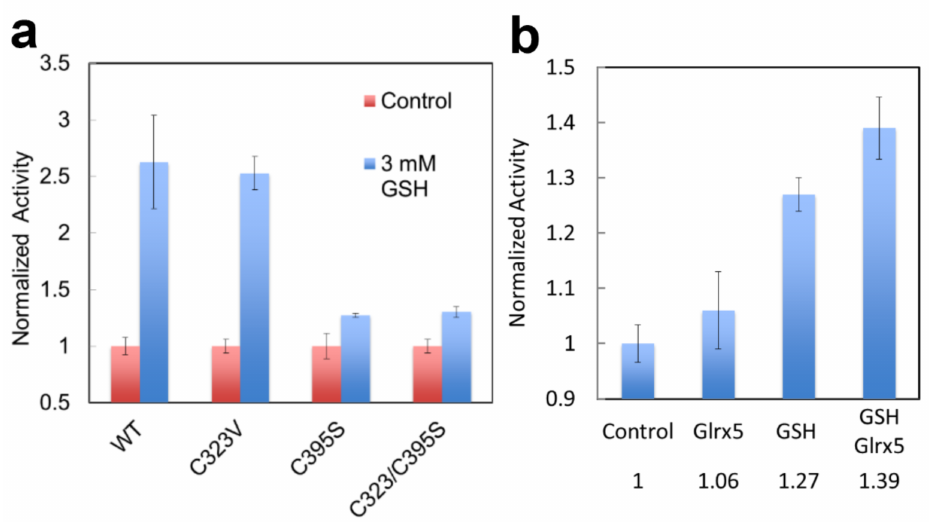
Figure 9. Enzyme activity of glutathionylated human FECH. Medlock and Dailey personal com- munication. ( a ) The activity of WT and C variants assayed +/ − 3 mM GSH. ( b ) The activity of FECH pre-incubated with Glrx5, 50 mM GSH, or both, and then assayed in the absence of GSH. Proteins were purified [98] and assayed [100] as previously described. Experiments were performed in